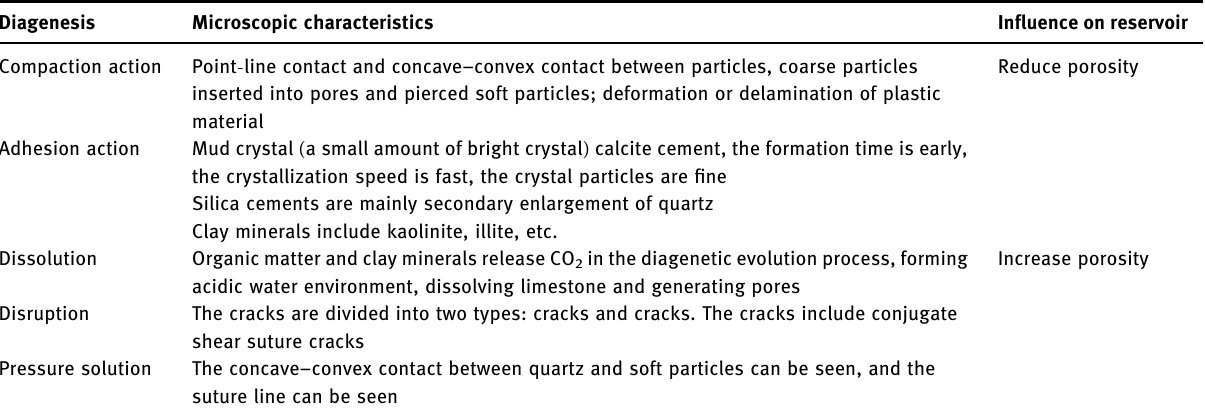
Table 2: Table of relationship between diagenesis and porosity